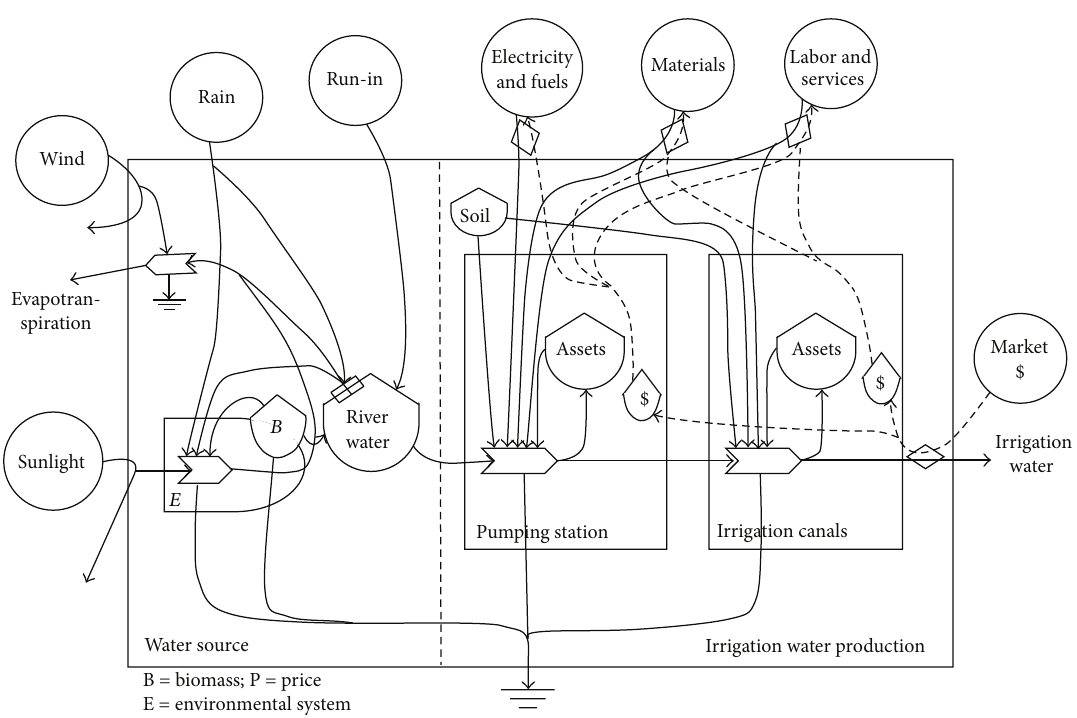
Figure 2: Energy systems diagram of the pumping irrigation water production system.